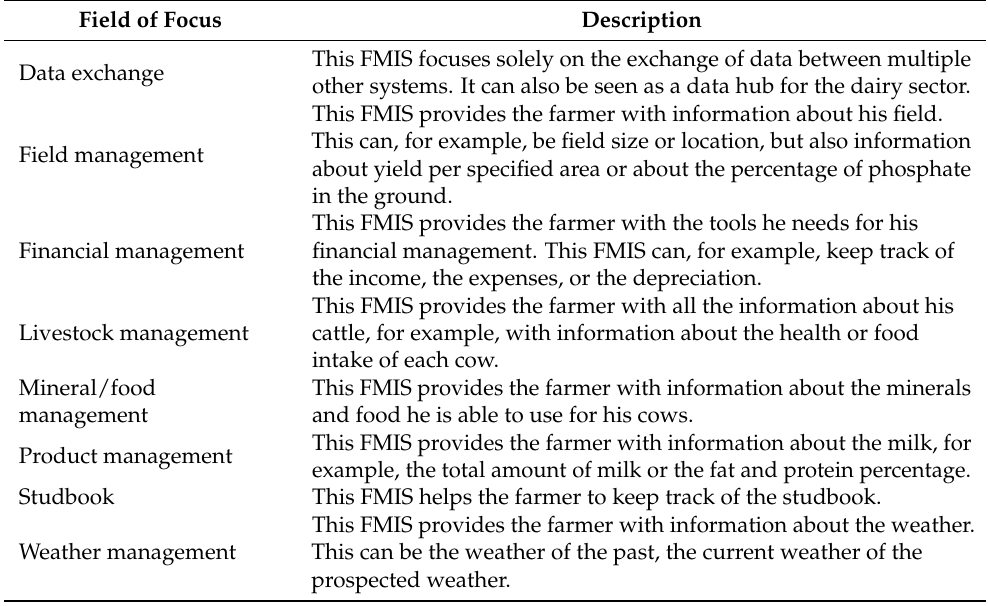
Table 2. The different fields of the focus of the dairy FMISs.